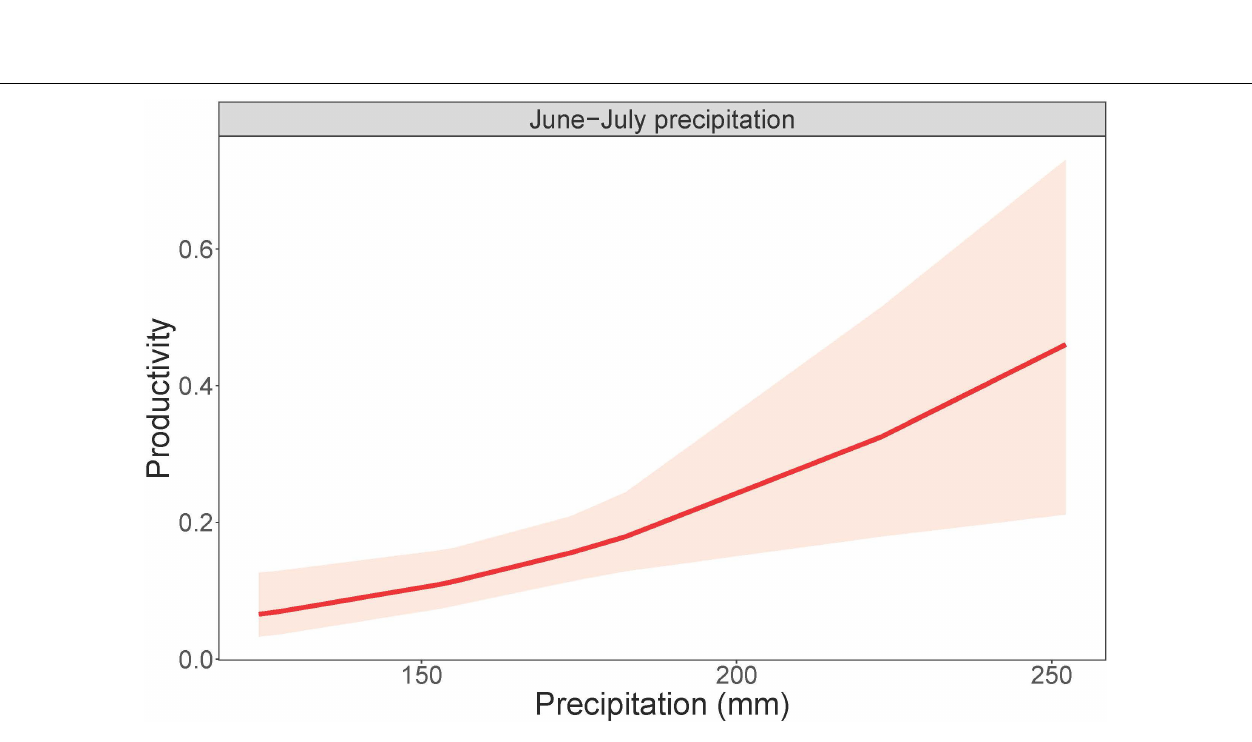
Frontiers in Ecology and Evolution |